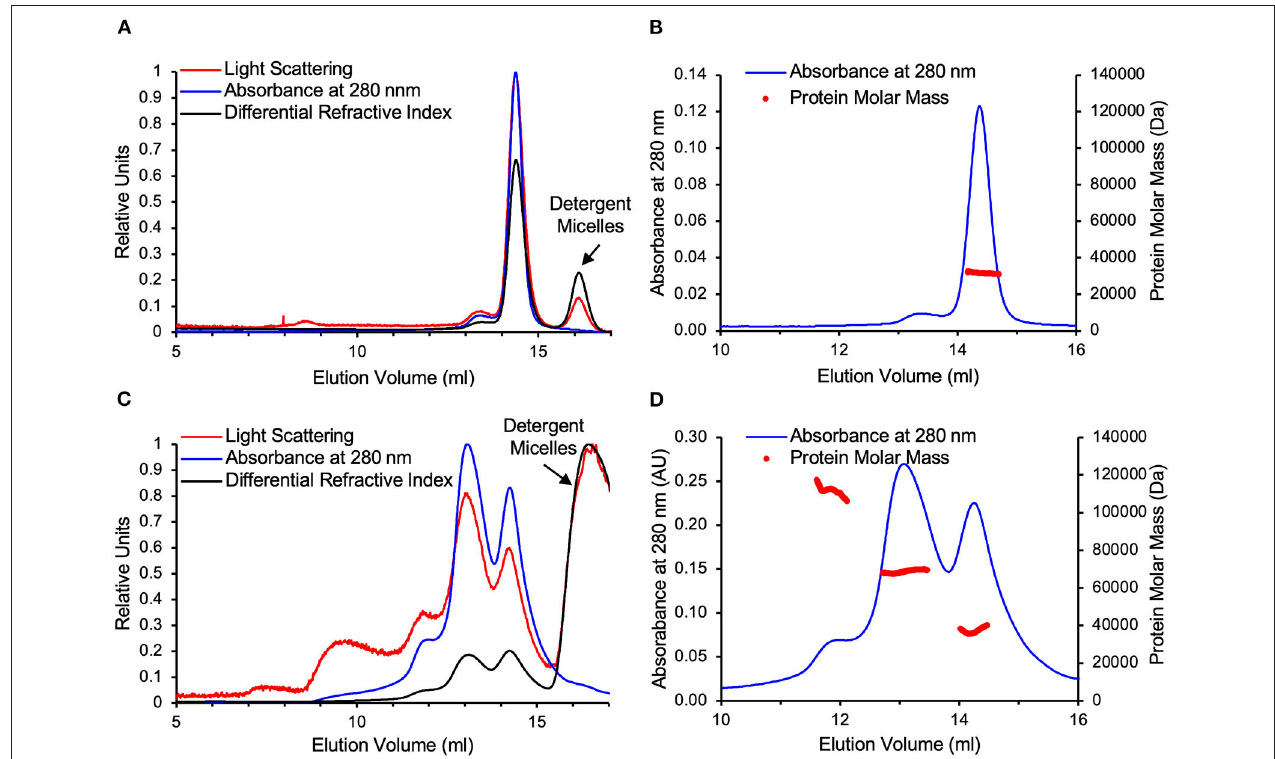
FIGURE 3 | WT-VDAC is monomeric and VDAC- 1 C is composed of monomers and dimers. (A) WT-VDAC. SEC with multi-angle light scattering (SEC-MALS) raw data on A relative scale. (B) WT-VDAC protein masses across the VDAC peak eluted from the SEC column. (C) VDAC- 1 C raw data on a relative scale. (D) VDAC- 1 C protein masses across the two major peaks eluted from the SEC column. WT-VDAC and VDAC- 1 C elutions are followed by the elution of excess detergent micelles from the injected samples, which are easily distinguished from VDAC species as they scatter visible light and alter the refractive index but do not absorb UV light. Detergent micelle peaks are indicated in (A) and (C)